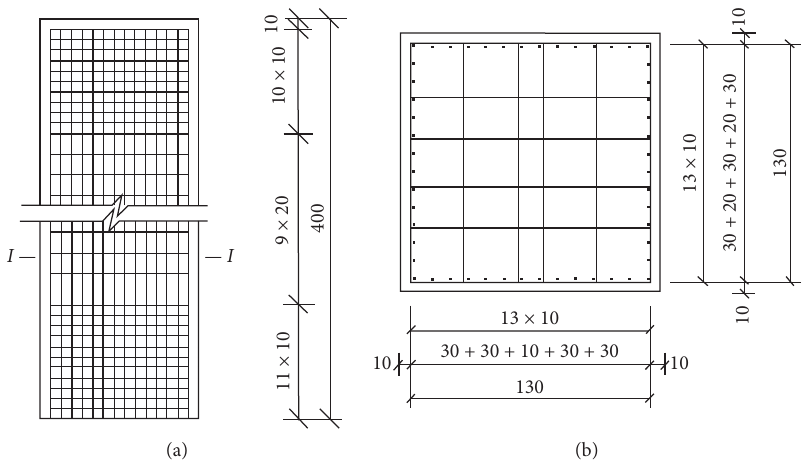
Figure 4: Dimensions of the pier (unit: cm): (a) sectional view and (b) cross-sectional view.